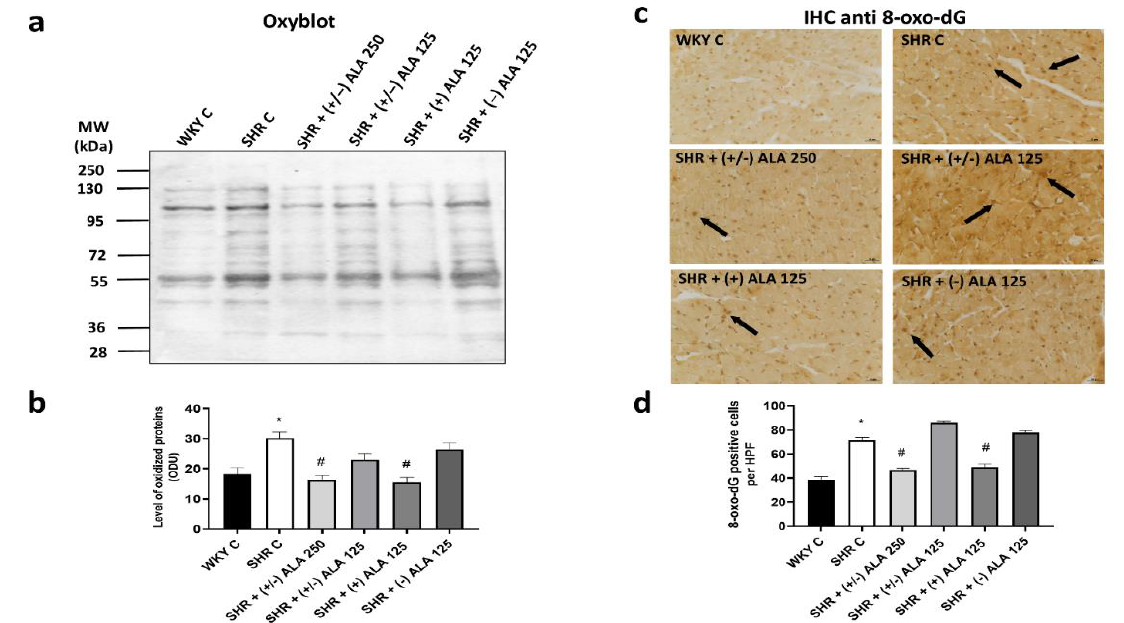
Figure 6. Oxidative stress in heart. ( a ) Lysates of heart from WKY C, SHR C, SHR + (+/ − ) alpha lipoic acid (ALA) 250 µmol/kg/day, SHR + (+/ − ) ALA 125 µmol/kg/day, SHR + (+) ALA 125 µmol/kg/day, SHR + ( − ) ALA 125 µmol/kg/day were immunoblotted using the Oxyblot kit; ( b ) The bar graph reports the level of oxidized proteins measured in optical density unit (ODU); ( c ) Sections of heart processed for the 8-oxo-dG immunohistochemistry (IHC). Arrow: positive nucleus. Cal- ibration bar 25 µm; ( d ) The bar graph shows the quantification of the number of positive cells per high-power field (HPF) (40×). Data are mean ± S.E.M. * p < 0.05 vs. WKY C; # p < 0.05 vs. SHR C.